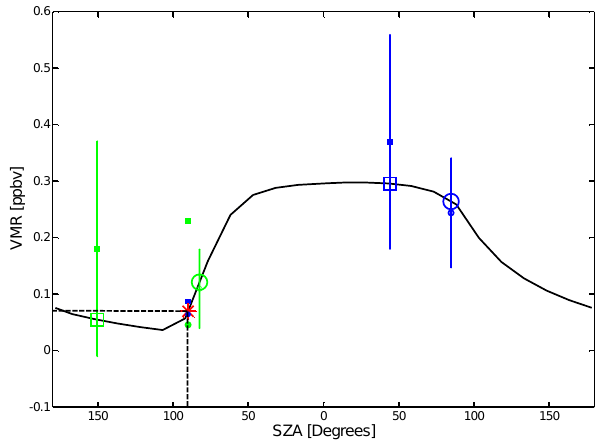
Fig. 6. An illustration of how the scale factors are calculated from Eq. (4) for measurements at z = 40km. ClO diurnal cy- cle (black line) as a function of time (SZA). Satellite observations Y obs (θ obs ,z ) are symbolized by either an open small circle (SMR) or an open small square (MLS). The observations are colour coded such that green=AM observations and blue=PM observations. The vertical solid lines are the corresponding measurement uncertain- ties. The large open circles correspond to Y mod (θ obs ,z ). The red asterisk is the Y mod (θ mod ,z ), where θ mod = 90 ◦ am. The resulting scaled measurements Y scl (θ mod ,z ) are shown as small filled circles (SMR) or squares (MLS). Corresponding scaled measurement un- certainties are not